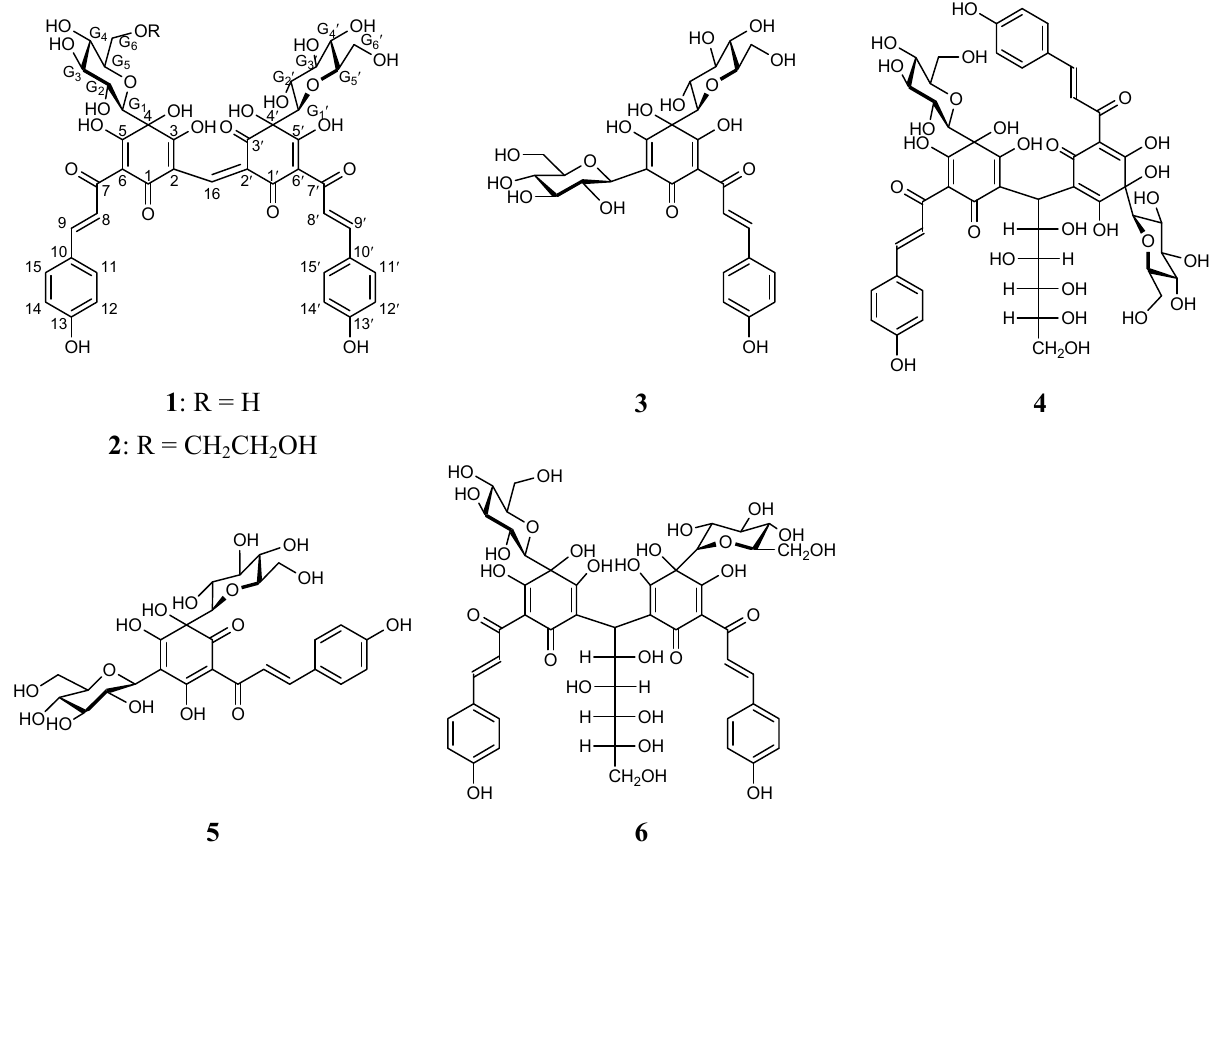
Figure 1. Quinochalcone C -glycosides isolated from Carthamus tinctorius